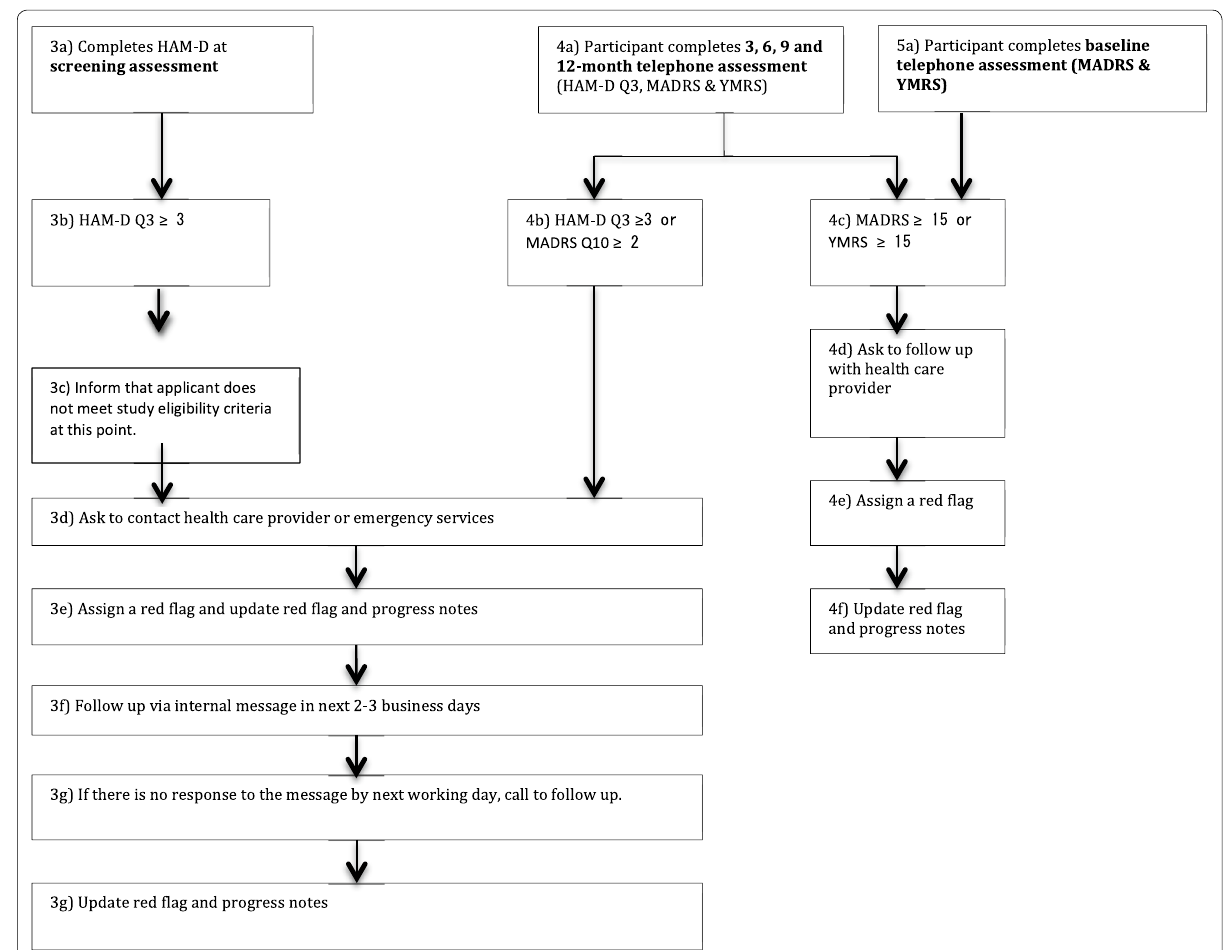
Fig. 3 MoodSwings 2.0 Red Flag Monitoring System flowchart: interview components. Figure includes detailed model for Red Flag Monitoring System designed to identify via routine phone interview methods study participants at high risk for suicidal behavior and provide guidance for services and